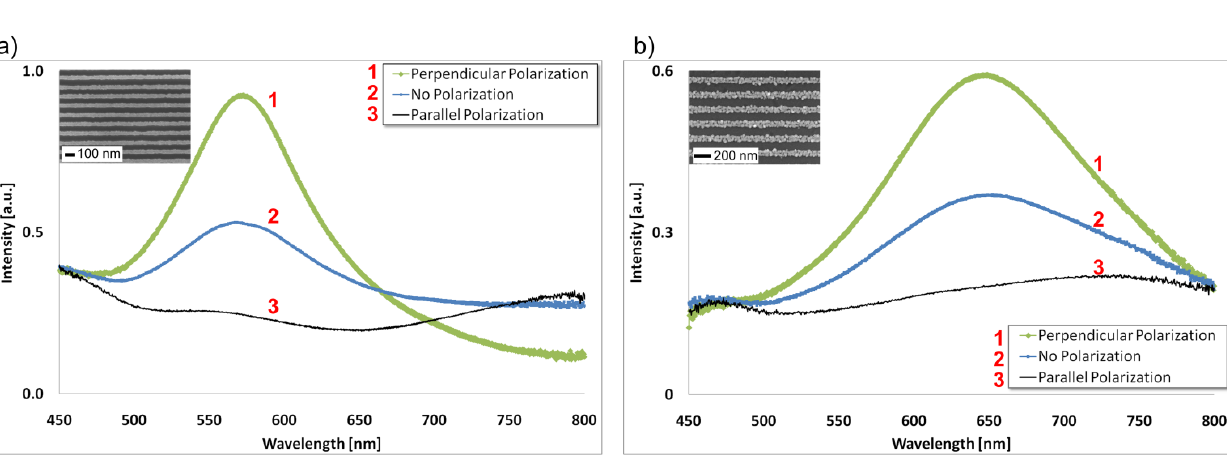
Figure 3. (a) A polarization dependent LSPR extinction spectrum of evaporated Au nanowires and (b) particle-based Au nanowires (200 nm period) in air. The most efficient excitation of localized surface plasmons can be achieved by perpendicular polarization with respect to the nanowire axis, but parallel polarized light results in almost no plasmon